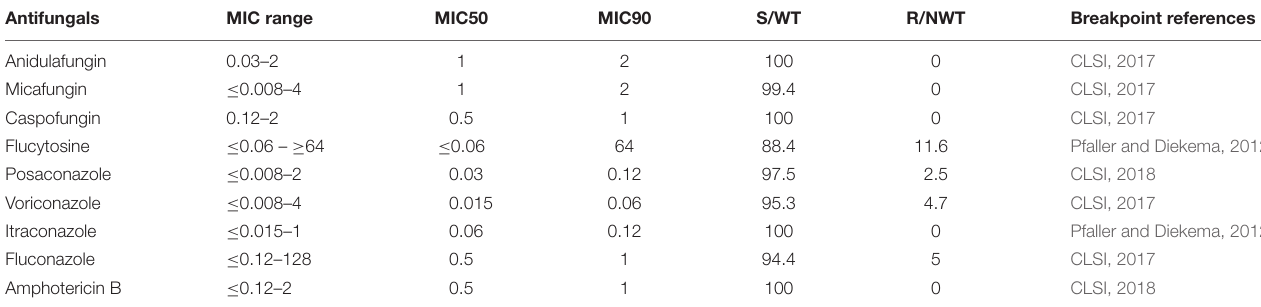
TABLE 2 | Antifungal susceptibility profiles of C. parapsilosis isolates ( µ g/mL). Antifungals